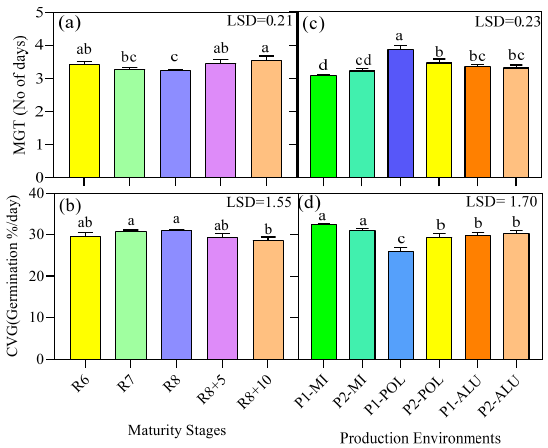
Figure 3. Mean germination time (MGT) and coefficient velocity of germination (CVG) as affected by different maturity stage ( a , b ) and different production environments (location × planting cycle) ( c , d ). Means followed by the same letter (s) on the bar do not differ significantly based on LSD at p < 0.05.